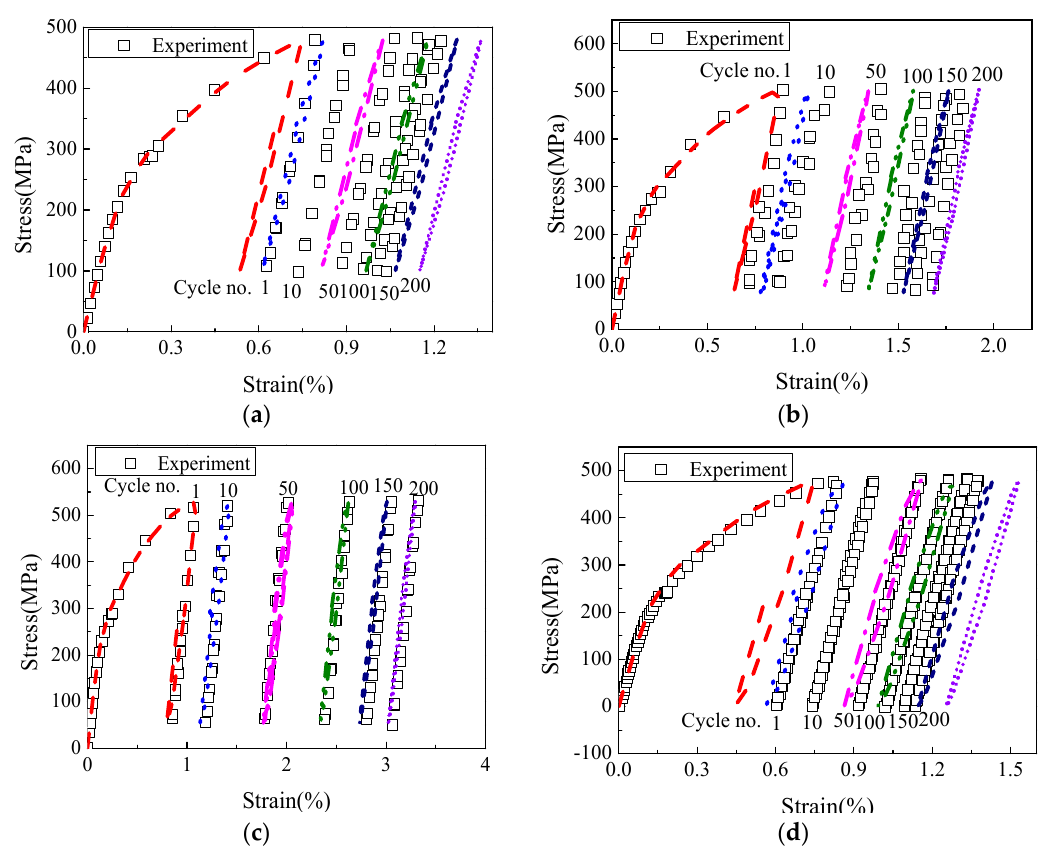
Figure 9. Simulation and experiment values of stress-strain response: ( a ) σ m = 290 MPa σ a = 190 MPa